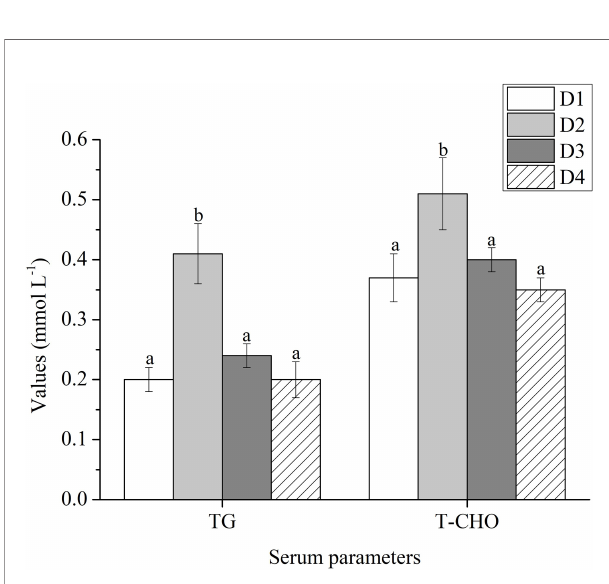
FIGURE 2 | The expression pro fi les of antioxidant-related genes in the liver of Trachinotus ovatus fed experimental diets for 56 days. Different superscript letters in the same row means the signi fi cant difference at P < 0.05. Mn-SOD, manganese superoxide dismutase; CAT, catalase; GSH-PX, glutathione peroxidase.